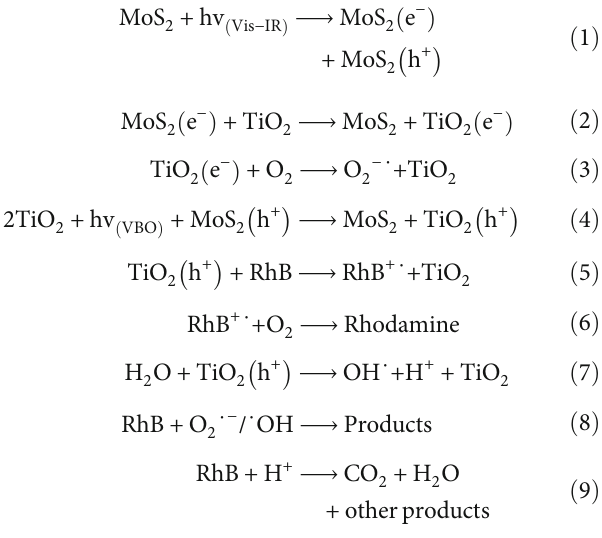
fi lm in the visible-infrared -MoS /TiO 2 2 2